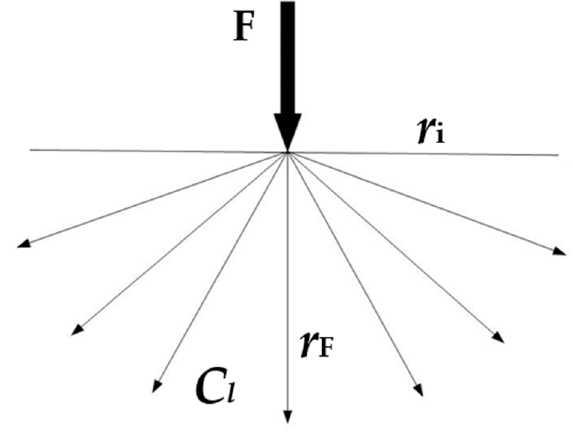
Figure 1. Directions of the longitudinal waves.